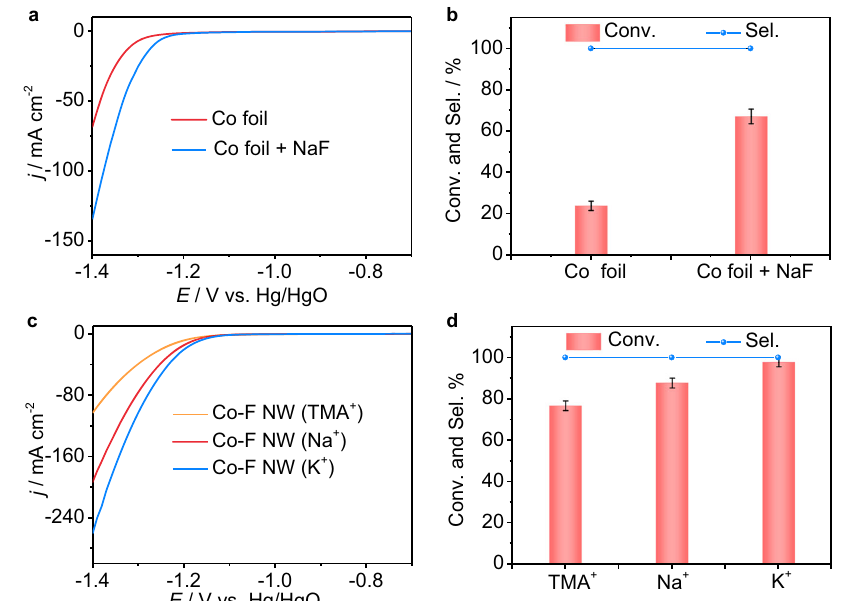
Fig. 3 | The effects of fl uorine and cations in the electrolyte on the electro- catalytic hydrogenation of 1 a . a LSV curves of Co foil recorded in 1.0M KOH without 1a atascanrateof10mVs − 1 ,and b1a Conv.and 2a Sel.overCofoilwithand without NaF. Reaction conditions: 1a (0.1mmol, 14.28mmolL − 1 ), a mixed solution of1.0MKOH/dioxane(6:1v/v,7mL), − 1.2V,6h,RT. c LSVcurvesofCo-Frecorded